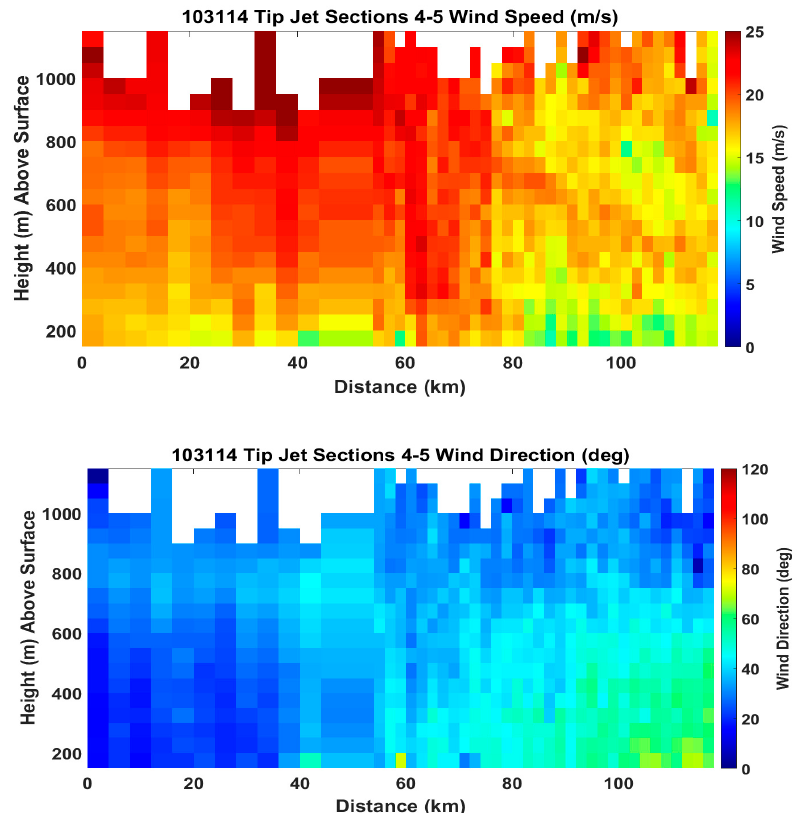
Figure 17. x–z cross section of DAWN wind speed ( top ) and direction ( bottom ) for combined segments 4 and 5 just south of the tip moving east to west on 31 October 2014.